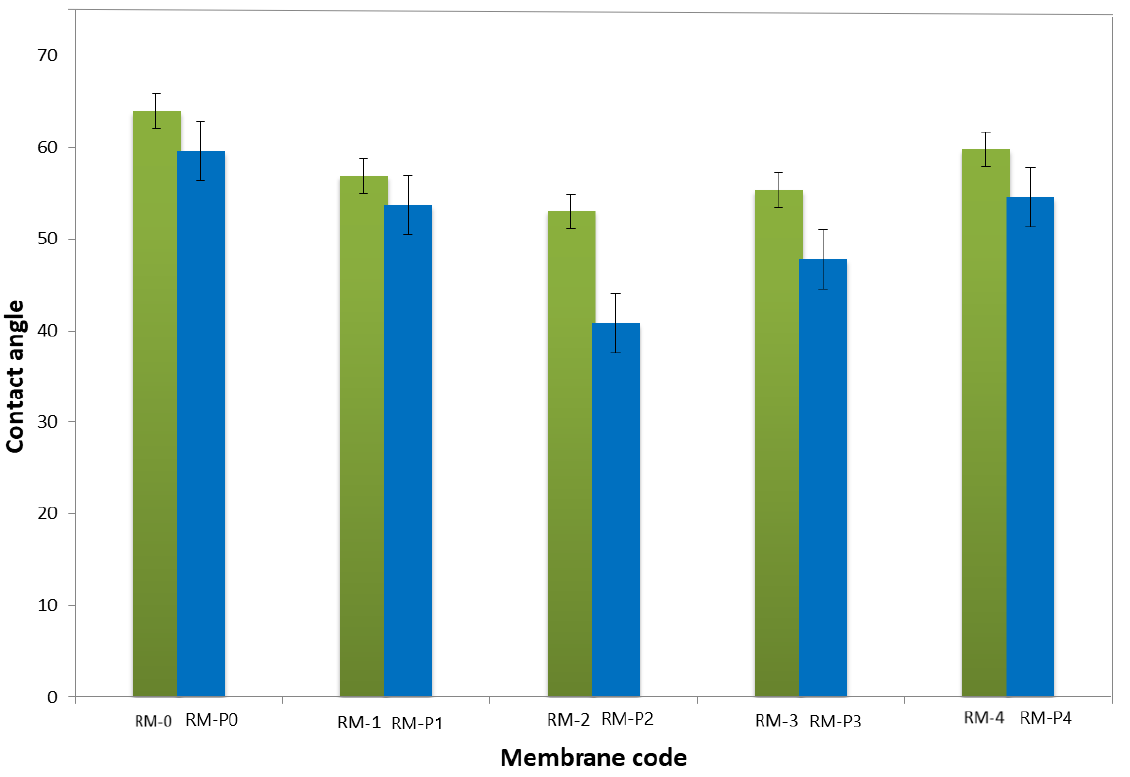
Figure 9. Contact angle of PPSU and PPSU/PVP membrane with various contents of GO-WO 2.89 wt. (%).